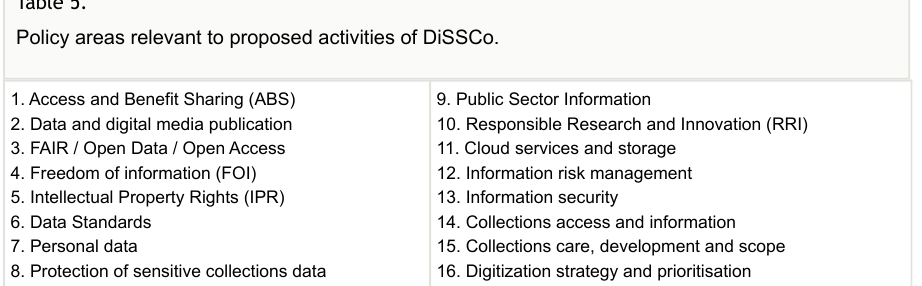
Conceptual design blueprint for the DiSSCo digitization infrastructure